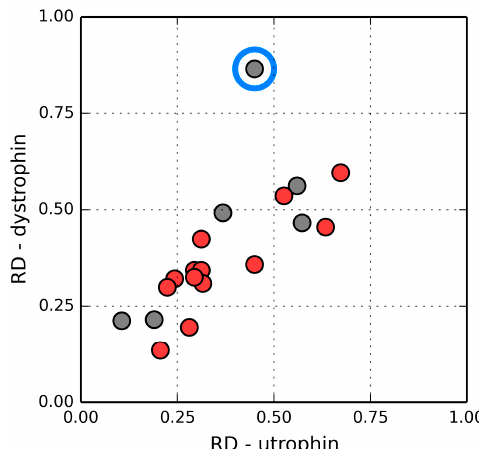
Figure 11. Relation between the status of individual secondary folds in dystrophin and in utrophin. The blue circle marks an outlier which corresponds to an exposed loop. Red: helices, gray: loops. Much like dystrophin, utrophin also contains a quasi-domain comprised of fragments contributed by individual chains (two helixes per chain). Figure 12 depicts these fragments (black fragment in chain A and red fragment in chain B. The resulting structure is hydrophobically stable, with an RD value of 0.453 (Table 7), indicating the presence of a well-defined hydrophobic core which stabilizes the complex. Table 7. RD values calculated for the AB complex, for chains A and B and for individual domains of utrophin (1QAG), as well as for selected secondary structural folds. “Fod Domain” represents fragments contributed by two chains (A,B) which form a coherent quasi-domain with its own FOD-compliant hydrophobic core.